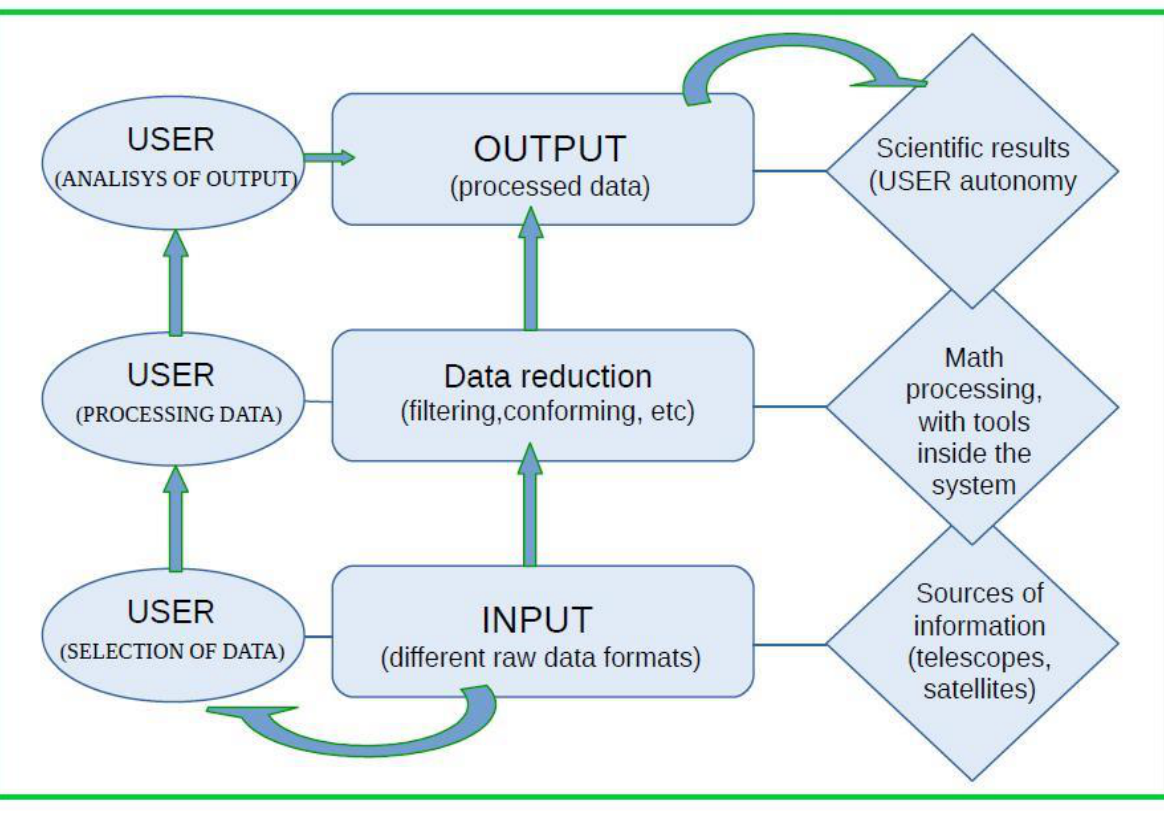
Figure 4: Simplified Flowchart of Space Data